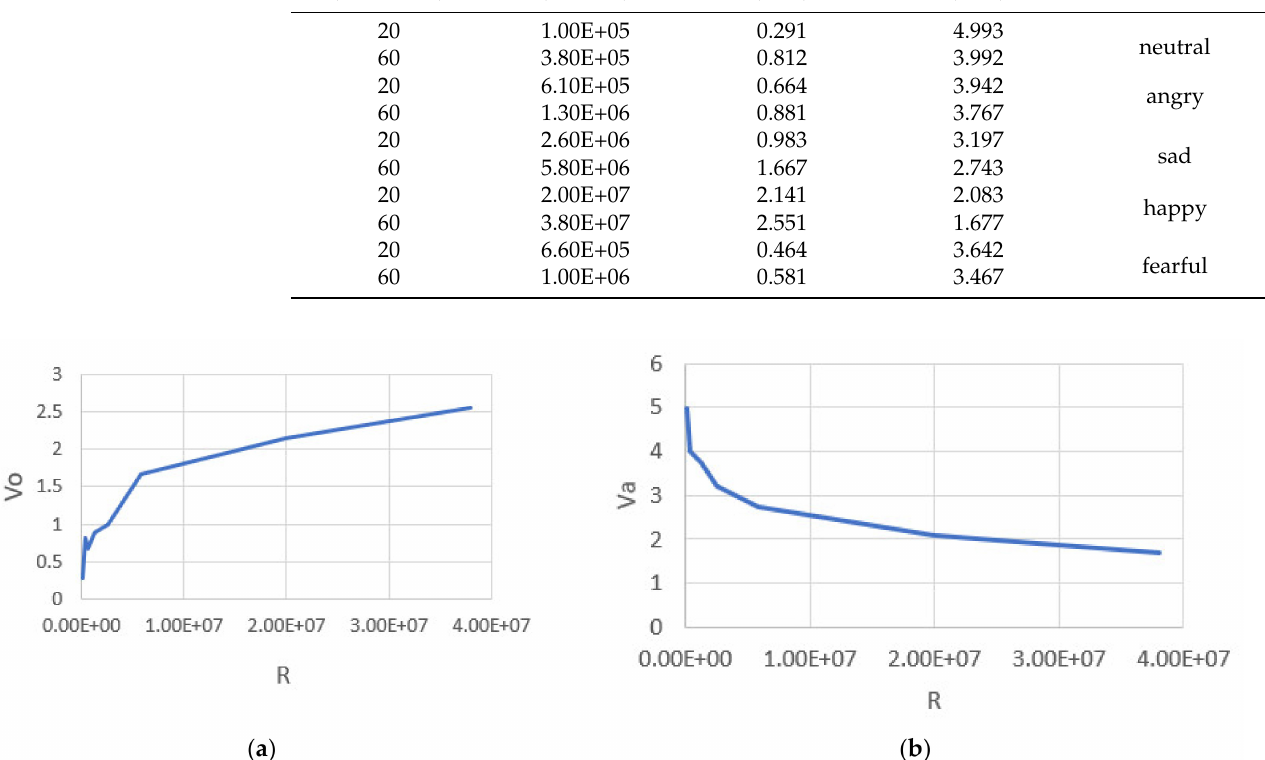
Figure 4. ( a ). V o vs. R based on a change in emotions. ( b ). V a vs. R based on a change in